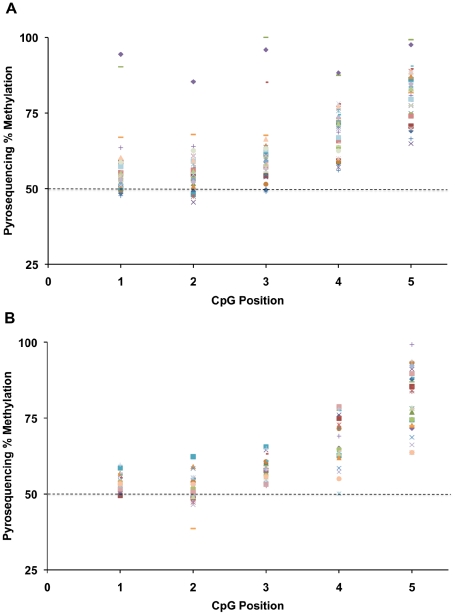
Pyrosequencing methylation at the IGF2/H19 DMR in placenta.(A) 31 in vivo individuals, and (B) 26 in vitro individuals. The methylation results at each CpG site for each individual are represented by a horizontal series of symbols. All but a few of the CpGs show methylation levels of 50% or higher, which is in concordance with our findings of gain of methylation on the maternal allele (M/P ≥0.15 in placenta, Figure 1).